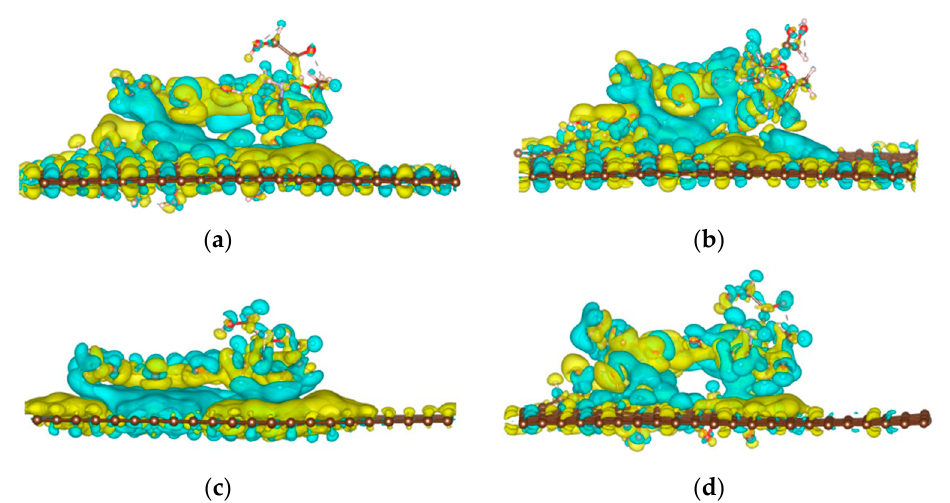
Figure 9. Differential charge density of different molecular graphene surfaces. ( a ) G-DOX; ( b ) GO- OH-DOX; ( c ) GO-O-DOX; ( d ) GO-OH-O-DOX. The yellow and blue areas represent an increase and decrease in charge density, respectively.